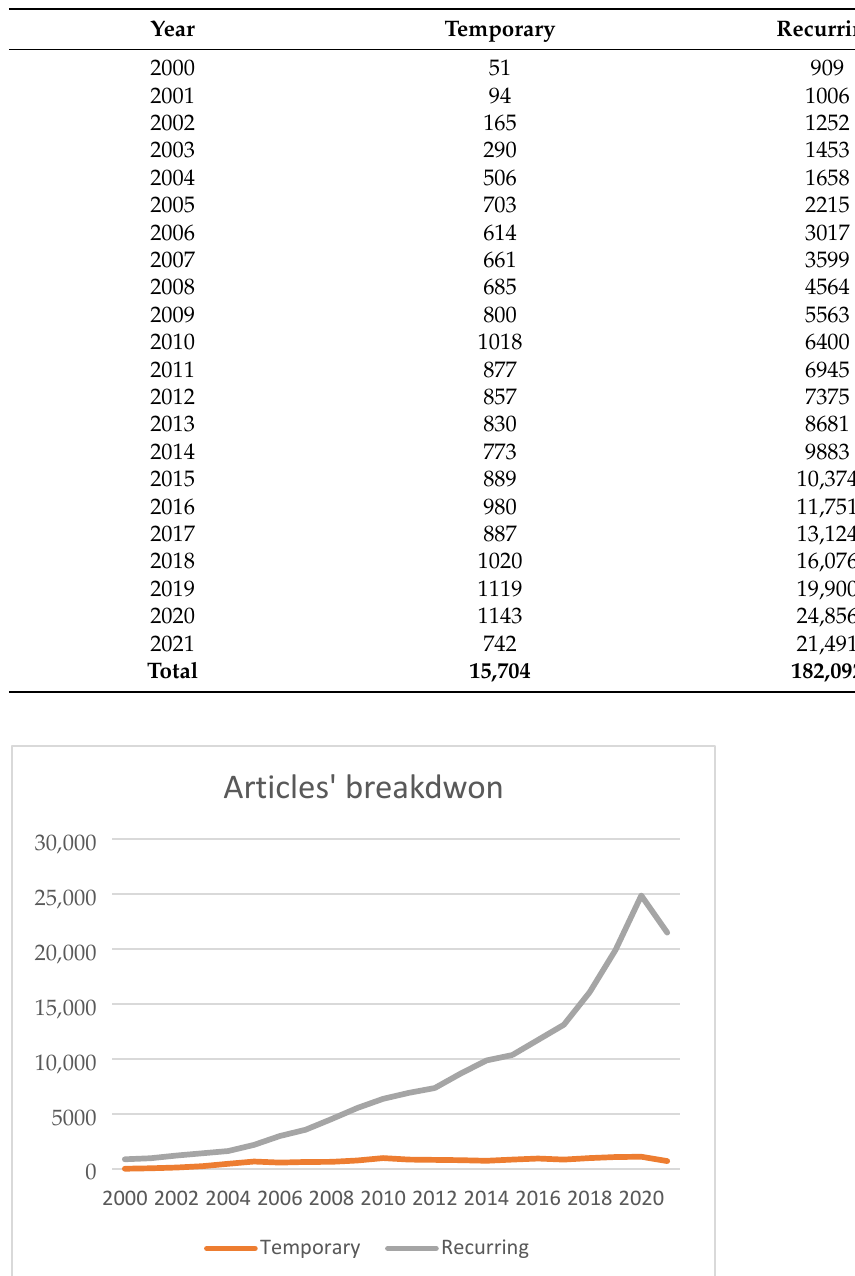
Table 2. Breakdown of the articles based on the publication year.